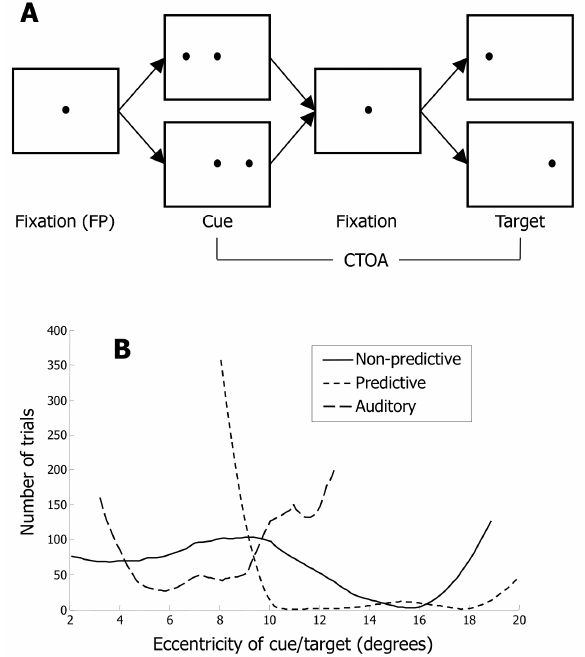
Figure 1. (A) Schematic representation of the cue used. Each trial began with the animal fixa fixation point (FP). After a variable time a brief visual or auditory cue was presented on the then maintained fixation again for another variable time: the cue-target onset asynchrony (CTOA). The fixation point was then extinguished and a visual target appeared to the left or right at the same eccentricity as the c preformed in separate experiments such that the animals performed blocks with visual cues that were either non predictive or predictive or separate blocks in which auditory cues were non-predictive. (B) Histograms of cue eccentricities used in each experiment Horizontal and vertical eye position data ed with the search coil system and were digitized 1KHz for experiments 1 and 2